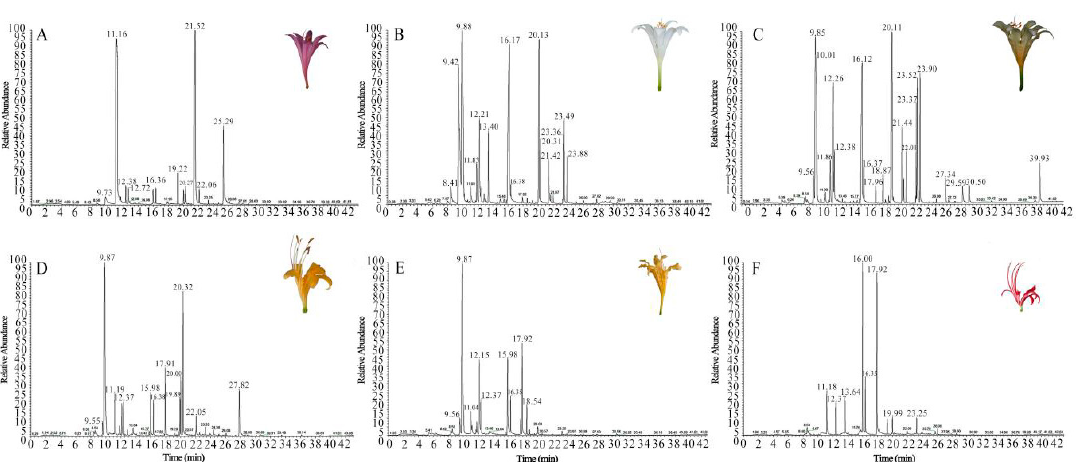
Figure 1. GC-MS total ion chromatograms of volatile organic compounds in six Lycoris taxa. ( A ) L. sprengeri ; ( B ) L. longituba ; ( C ) L. longituba var. flava ; ( D ) L. aurea ; ( E ) L. chinensis ; ( F ) L. radiate .